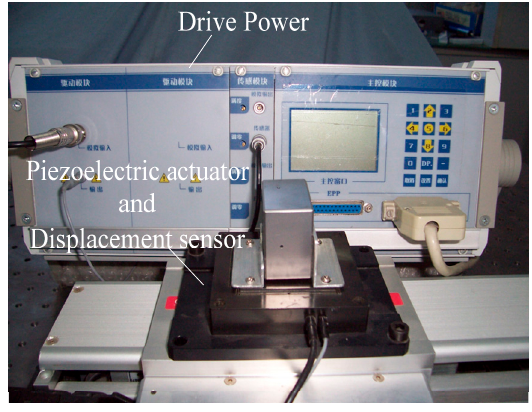
Figure 3. The PZA experiment devices.